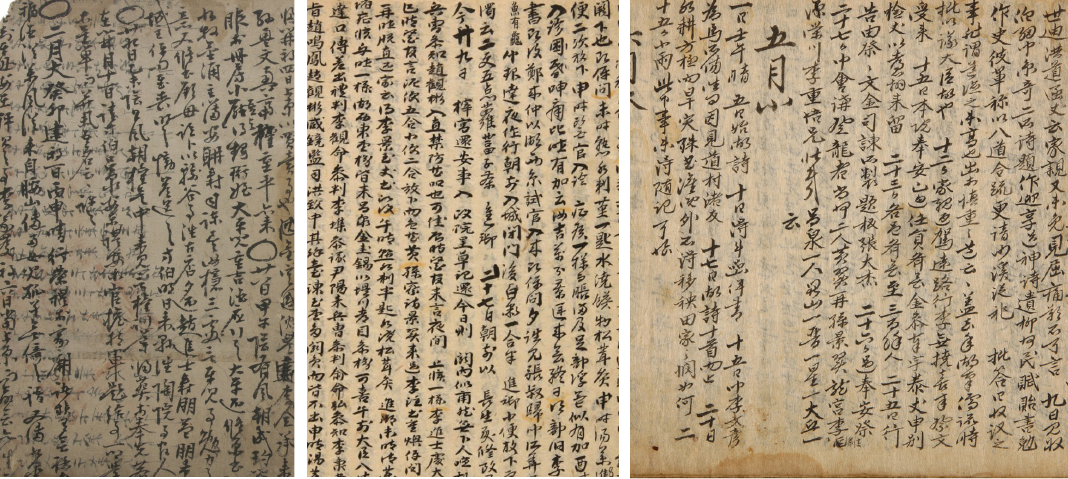
Figure 7. Example of caoshu data-set augmentation using a random